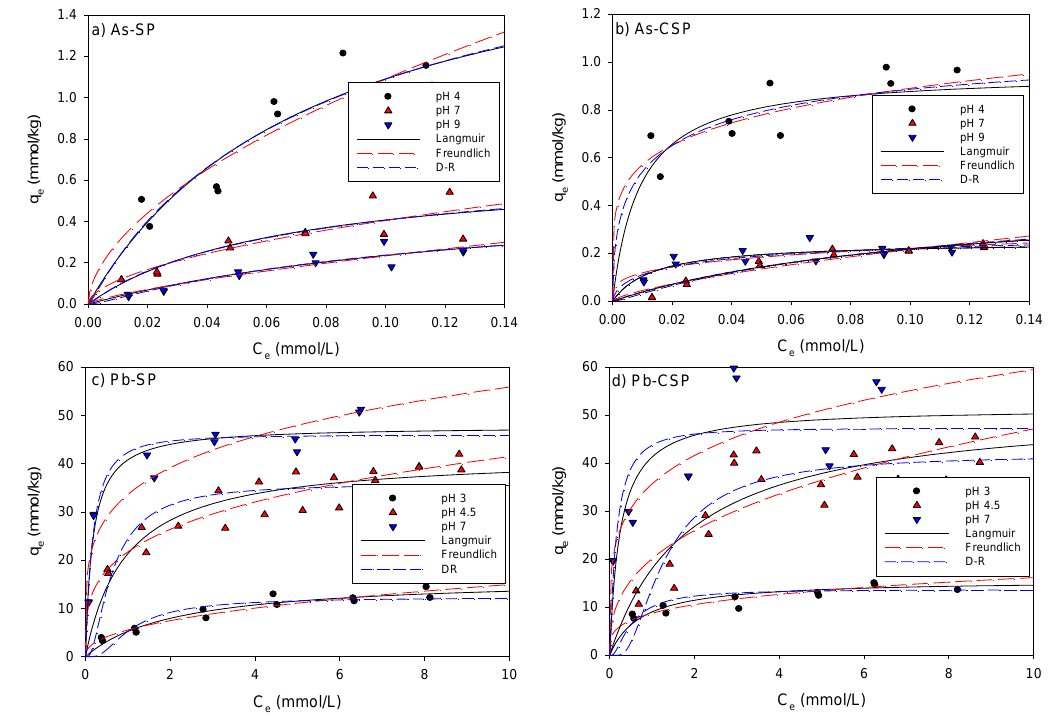
Figure 5. Effect of pH on ( a , b ) As and ( c , d ) Pb adsorption onto ( a , c ) SP and ( b , d ) CSP.